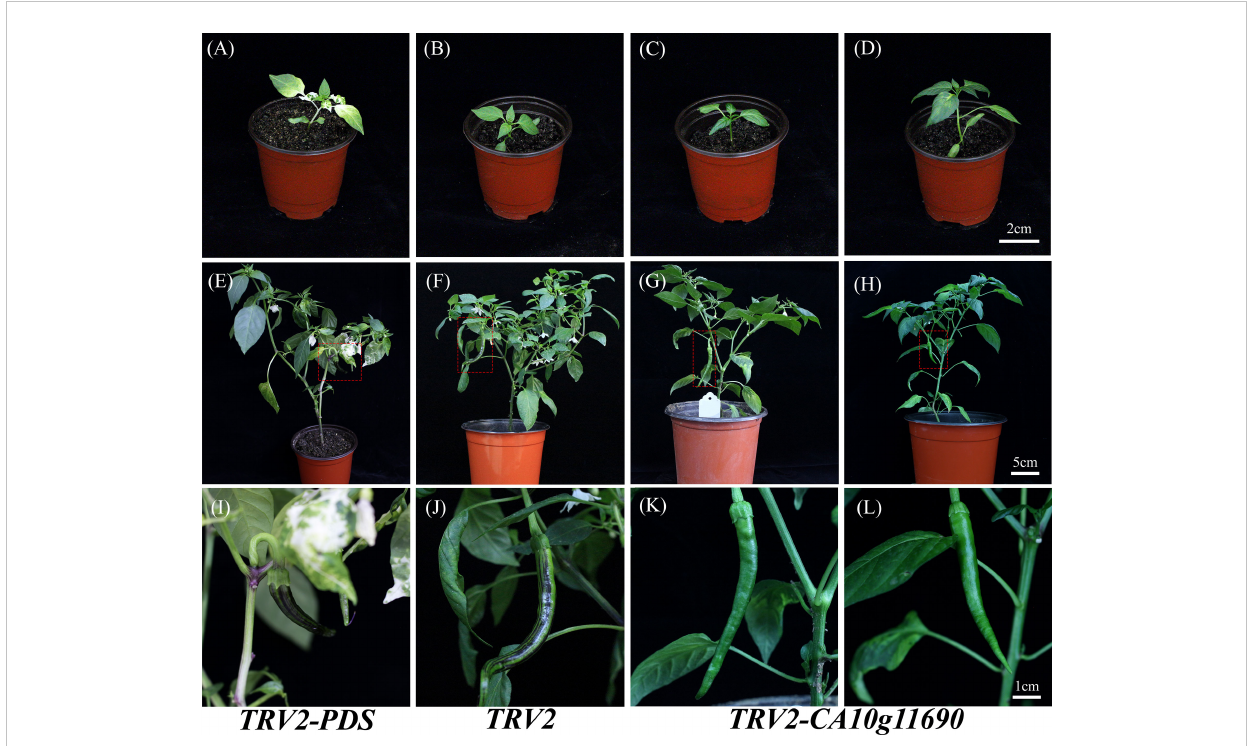
FIGURE 6 Silencing the candidate gene CA10g11690 in Chen12-4 via mediated VIGS and gene expression patterns. (A, E, I) are PDS-silenced plants. (B, F, J) are TRV2- treated plants. (C, D, G, H, K, L) are CA10g11690 -silenced plants; The red boxed regions in (E – H) are magni fi ed in (I – L) for better visualization. Representative phenotypes offruits from TRV2-PDS , TRV2 , and TRV2 - CA10g11690 plants. TRV2-PDS and TRV2 plants were used as negative and positive controls, respectively, and only produced purple fruits. TRV2-CA10g11690 plants exhibited a complete loss of purple stripes on the